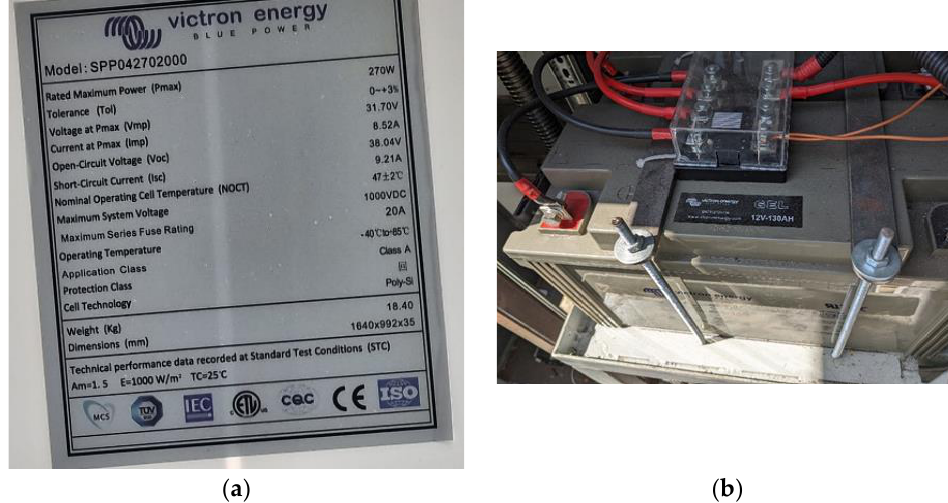
Energies 2022 , 15 , 4433